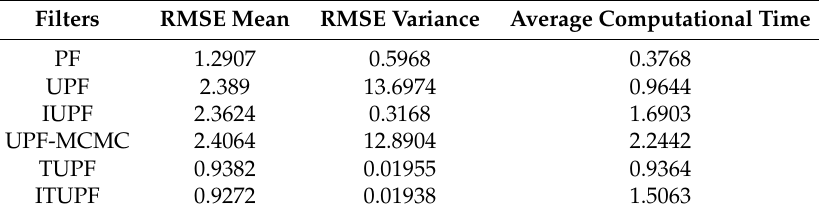
Table 1. RSME and computational time of different particle filters.